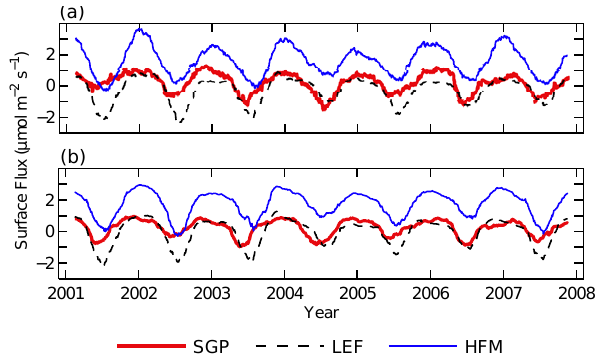
Fig. 5. Surface flux inferred from the equilibrium approximation (a) and the CT/TM5 assimilated surface flux (b) for SGP (red), LEF (dashed black), and HFM (blue), using 90-day averages. Equilib- rium fluxes (a) are given by the sum of horizontal and total vertical advection shown in Fig. 4.